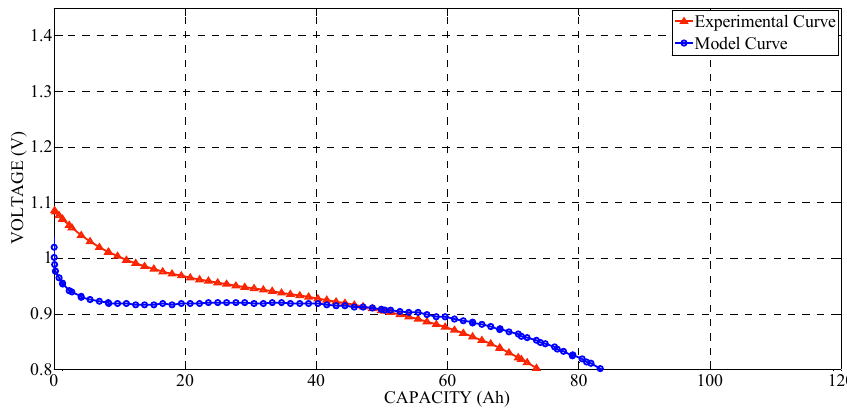
Figure 21. Discharge curve (5 C).